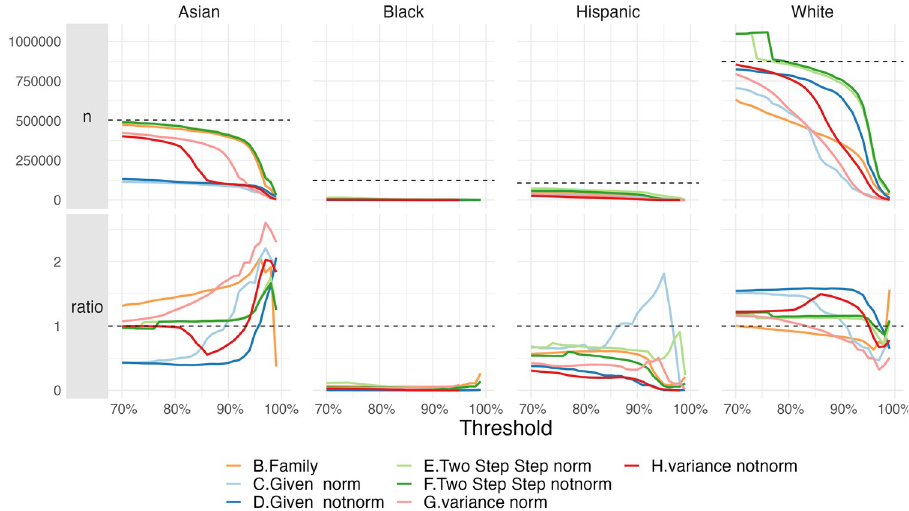
Fig 5. Retrieval of authors by race using different inference models for varying